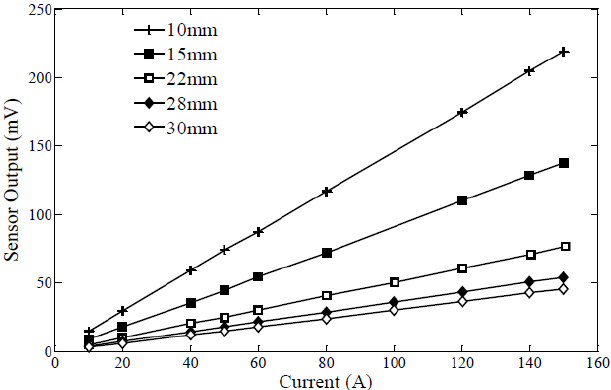
Figure 9. Sensor’s output (RMS voltage) with regard to the current passing through the wire (Output voltage is linearly proportional to the current intensity). Different plots represent different distances between the wire and the sensor [43].